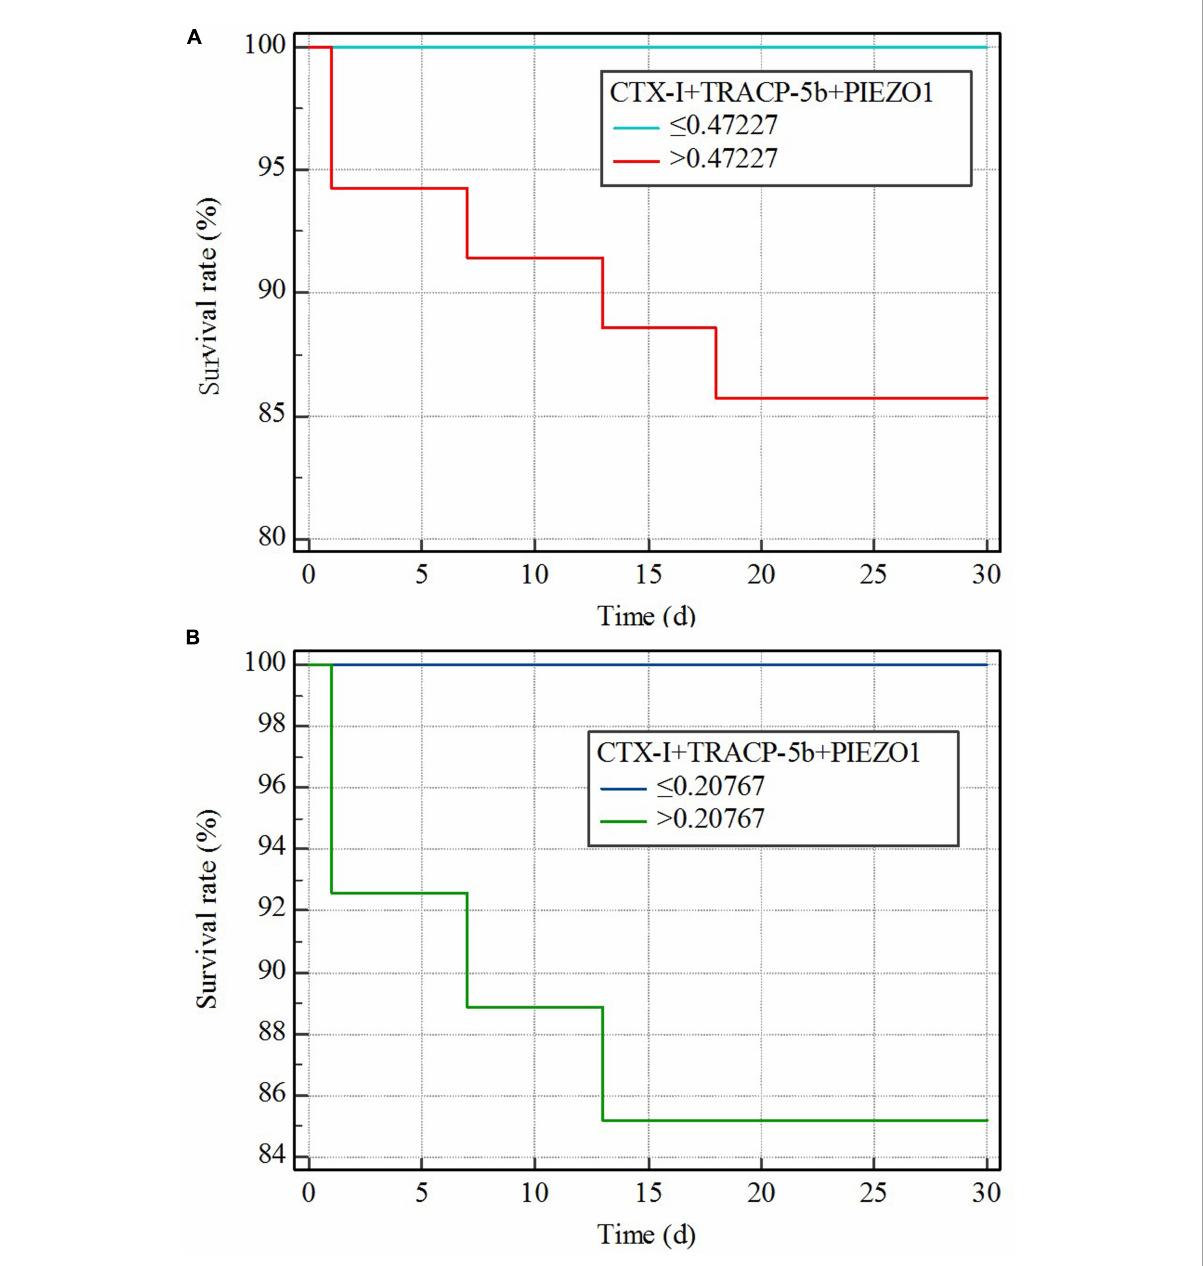
FIGURE6 Kaplan–Meier curves. (A) Sepsis vs. non-sepsis; (B) sepsis shock vs.